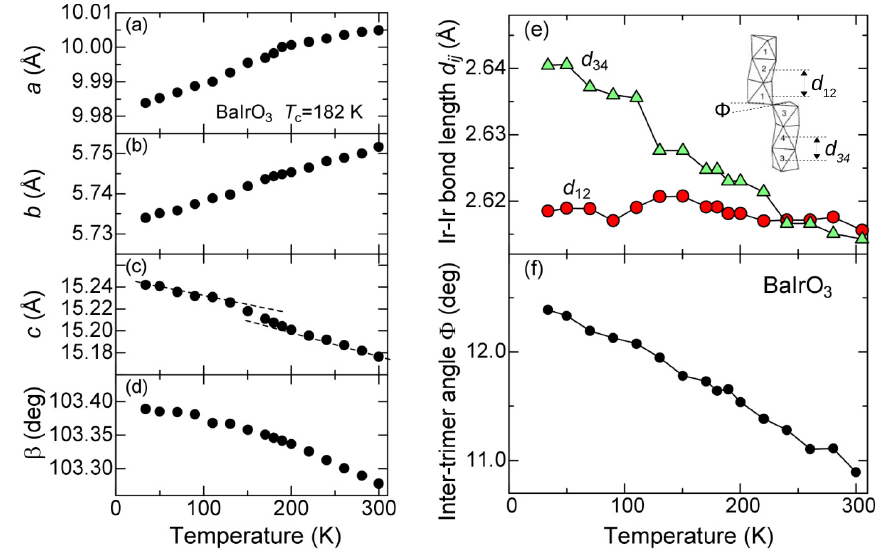
Figure 3. ( a – d ) lattice parameters of BaIrO 3 . ( a ) a -; ( b ) b -; and ( c ) c -axis length; ( d ) monoclinic angle β ; ( e ) The intra-timer Ir-Ir bond length d 12 and d 34 ; and ( f ) the inter-timer angle Φ . The inset schematically designates d 12 , d 34 and Φ